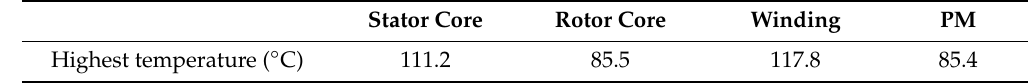
Table 6. The highest temperature of each component.